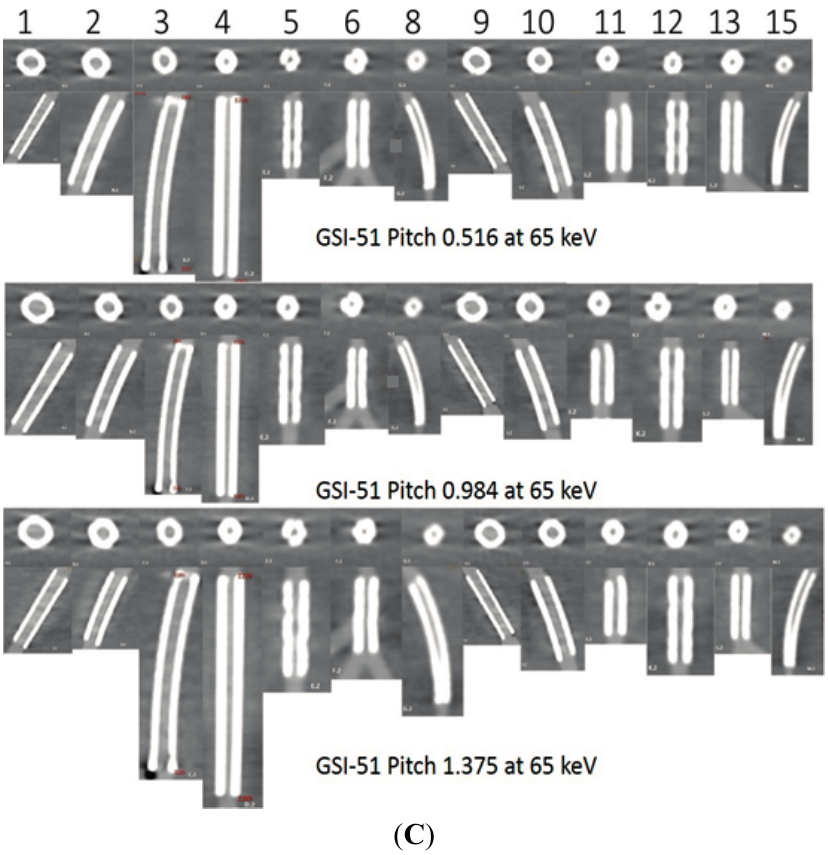
Figure 2. A total of 13 stents (No. 7 and 14 were not included due to difficulty placing region of interest in the area) with axial and coronal reformatted images were demonstrated with three GSI protocols ( A – C : GSI-36, GSI-48, and GSI-51, respectively) and three pitch values at a keV of